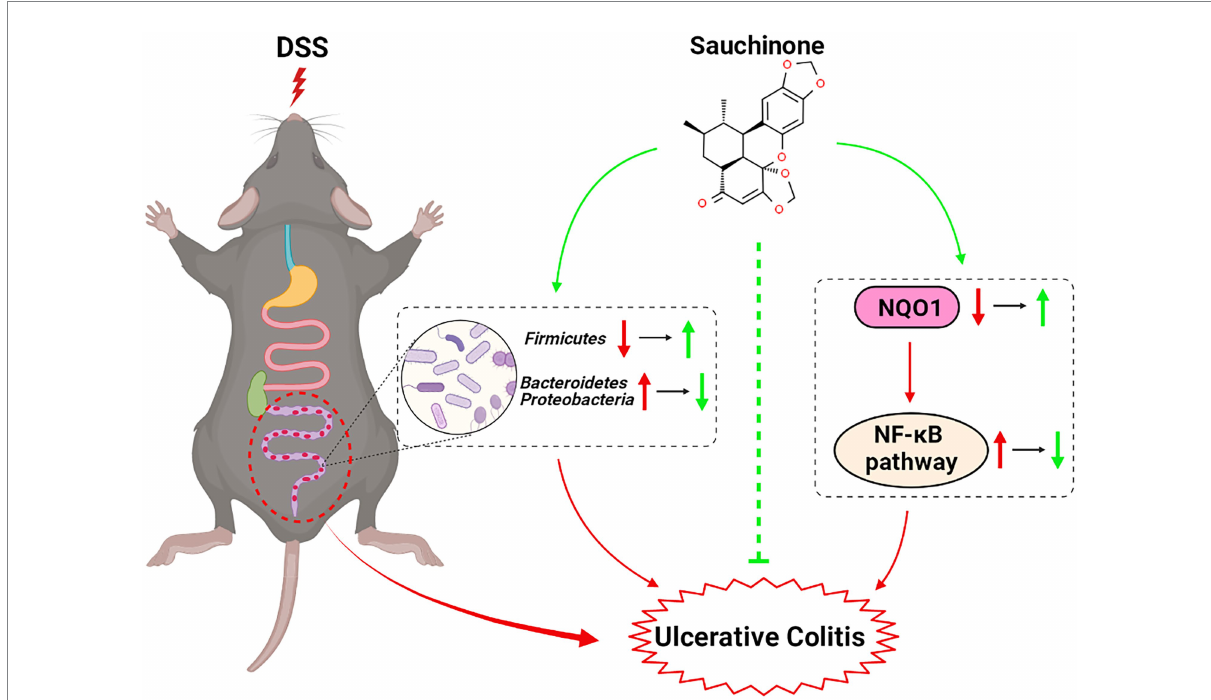
FIGURE 7 Schematic for the effects and mechanisms of sauchinone bioactivity in DSS-induced UC